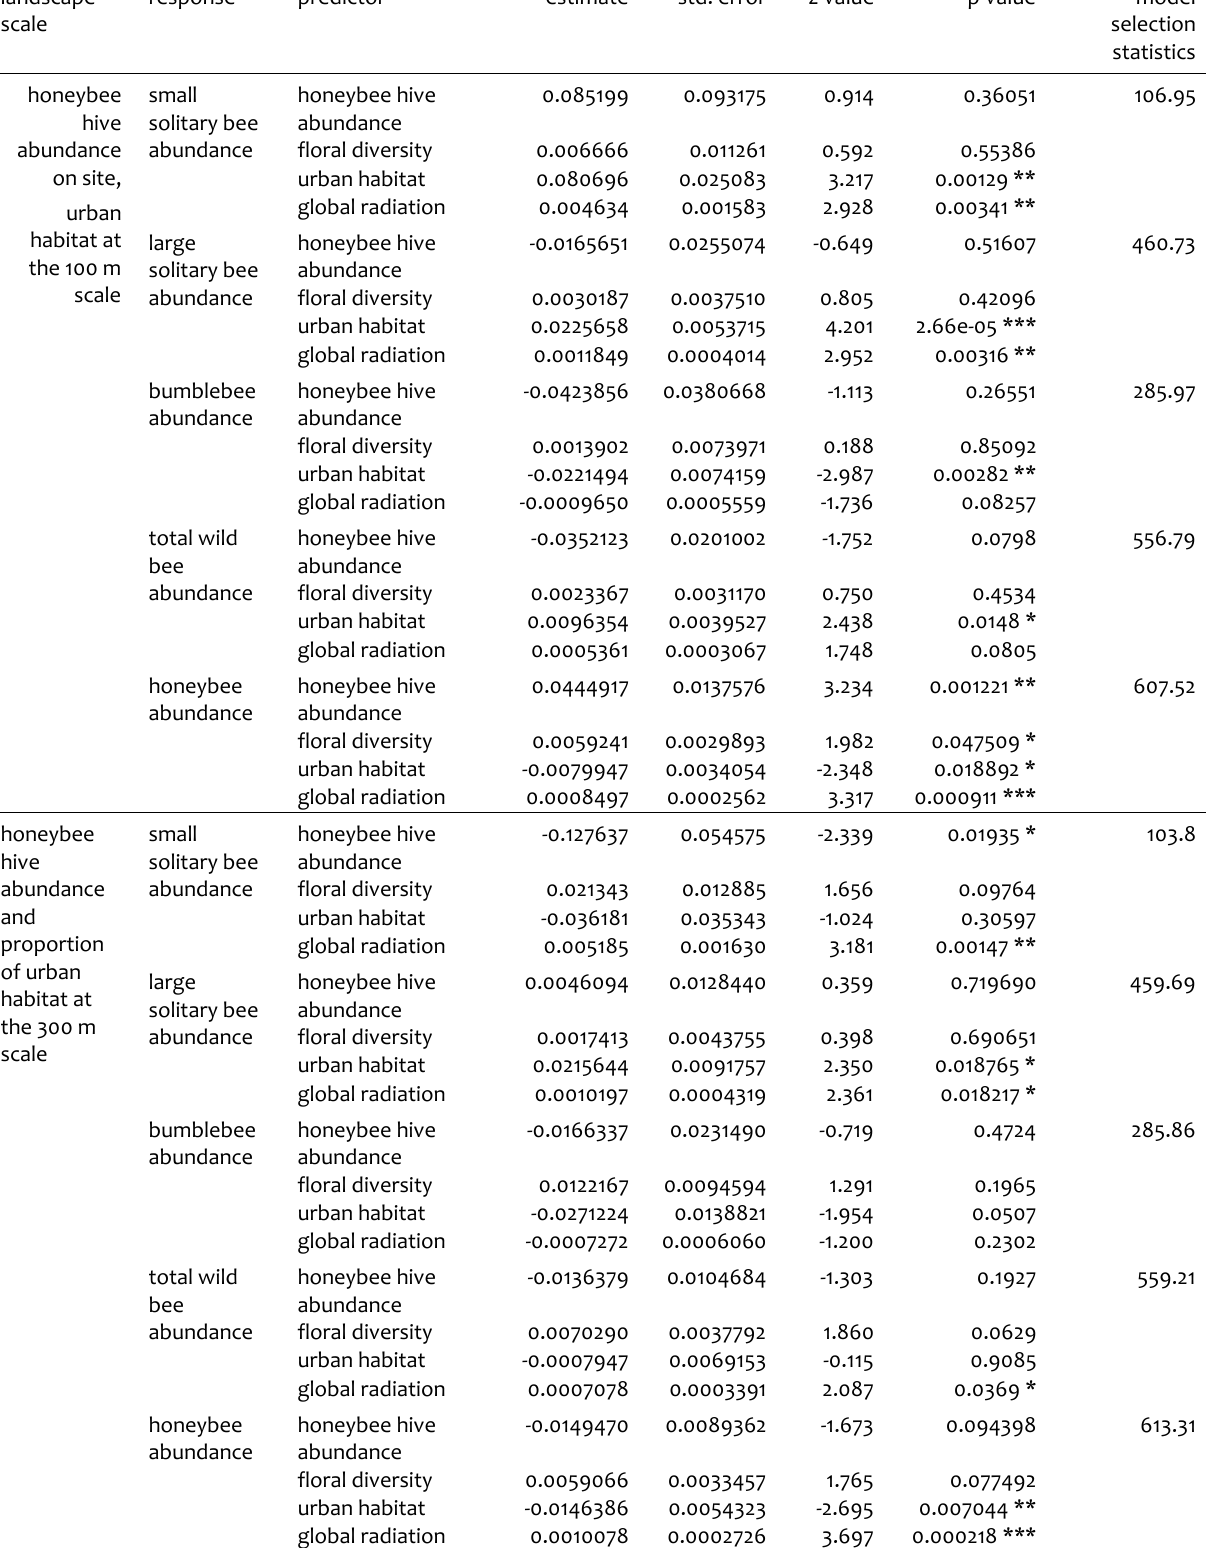
Table 11. Results of poisson regression models describing the effect of the number of honeybee hives at different landscape scales, of floral diversity on site, of the proportion of urban habitat at different landscape scales, and of global radiation on bee abundances on apple flowers. Each landscape scale and bee type represent a separate model. Estimated parameters, standard errors, z-values, p-values and model selection statistics are given. Significance is marked with * at P  0.1, * at P  0.05, ** at P  0.01 and *** at P 